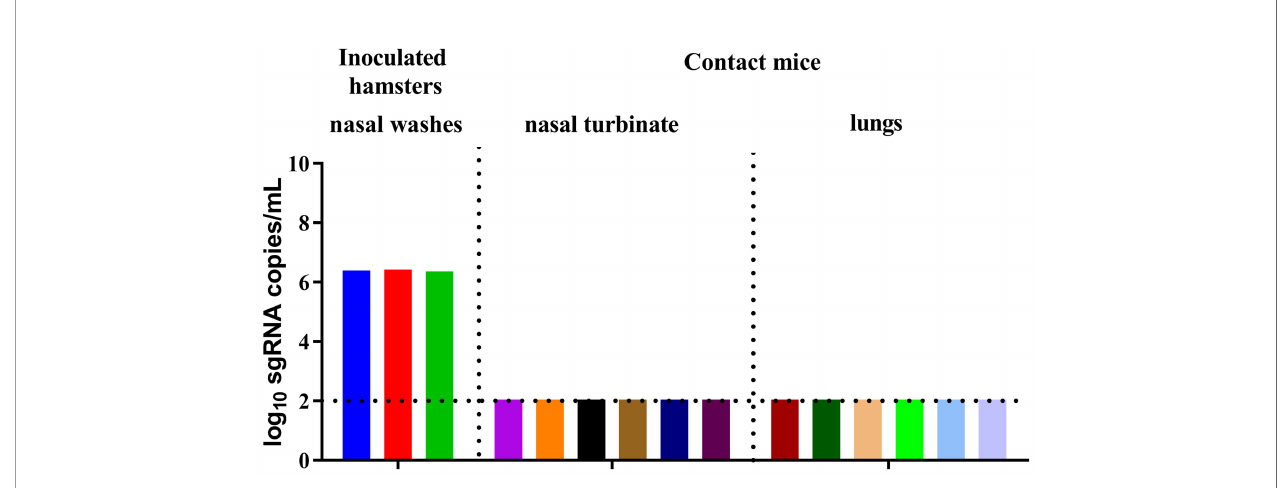
FIGURE 4 | SARS-CoV-2 B.1.351 variant transmission between male Syrian hamsters and female BALB/c mice. The dotted line represents the detection limit. Viral sgRNA copies